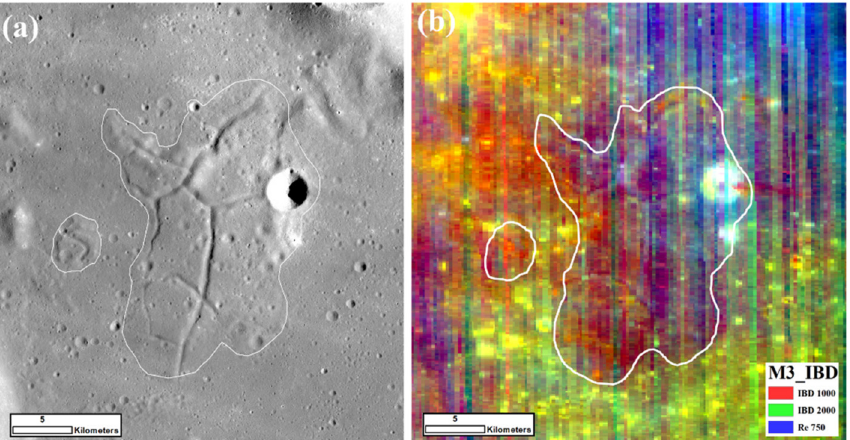
Figure 4. ( a ) A representative impact melt deposit in the western rim of the Crisium basin. This impact melt candidate is 10 km in diameter with a rough surface structure. The white lines denote this impact melt deposit. ( b ) The RGB map based on M 3 reflectance data indicates that this deposit has a feldspathic-rich signature. Red: IBD1000; green: IBD2000; blue: Re 750.